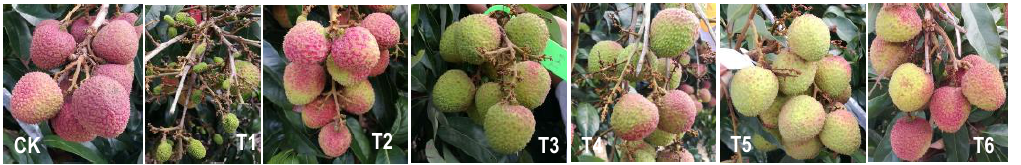
Figure 2. Effect of CPPU treated at different stages on fruit appearance in ‘Feizixiao’. CK represents the control, while T1, T2, T3, T4, T5 and T6 represent spraying 5 mg/L CPPU at 2, 4, 6, 8, 9 and 10 weeks after female bloom, respectively. Photos were obtained at 11 WAFB (result of 2018).